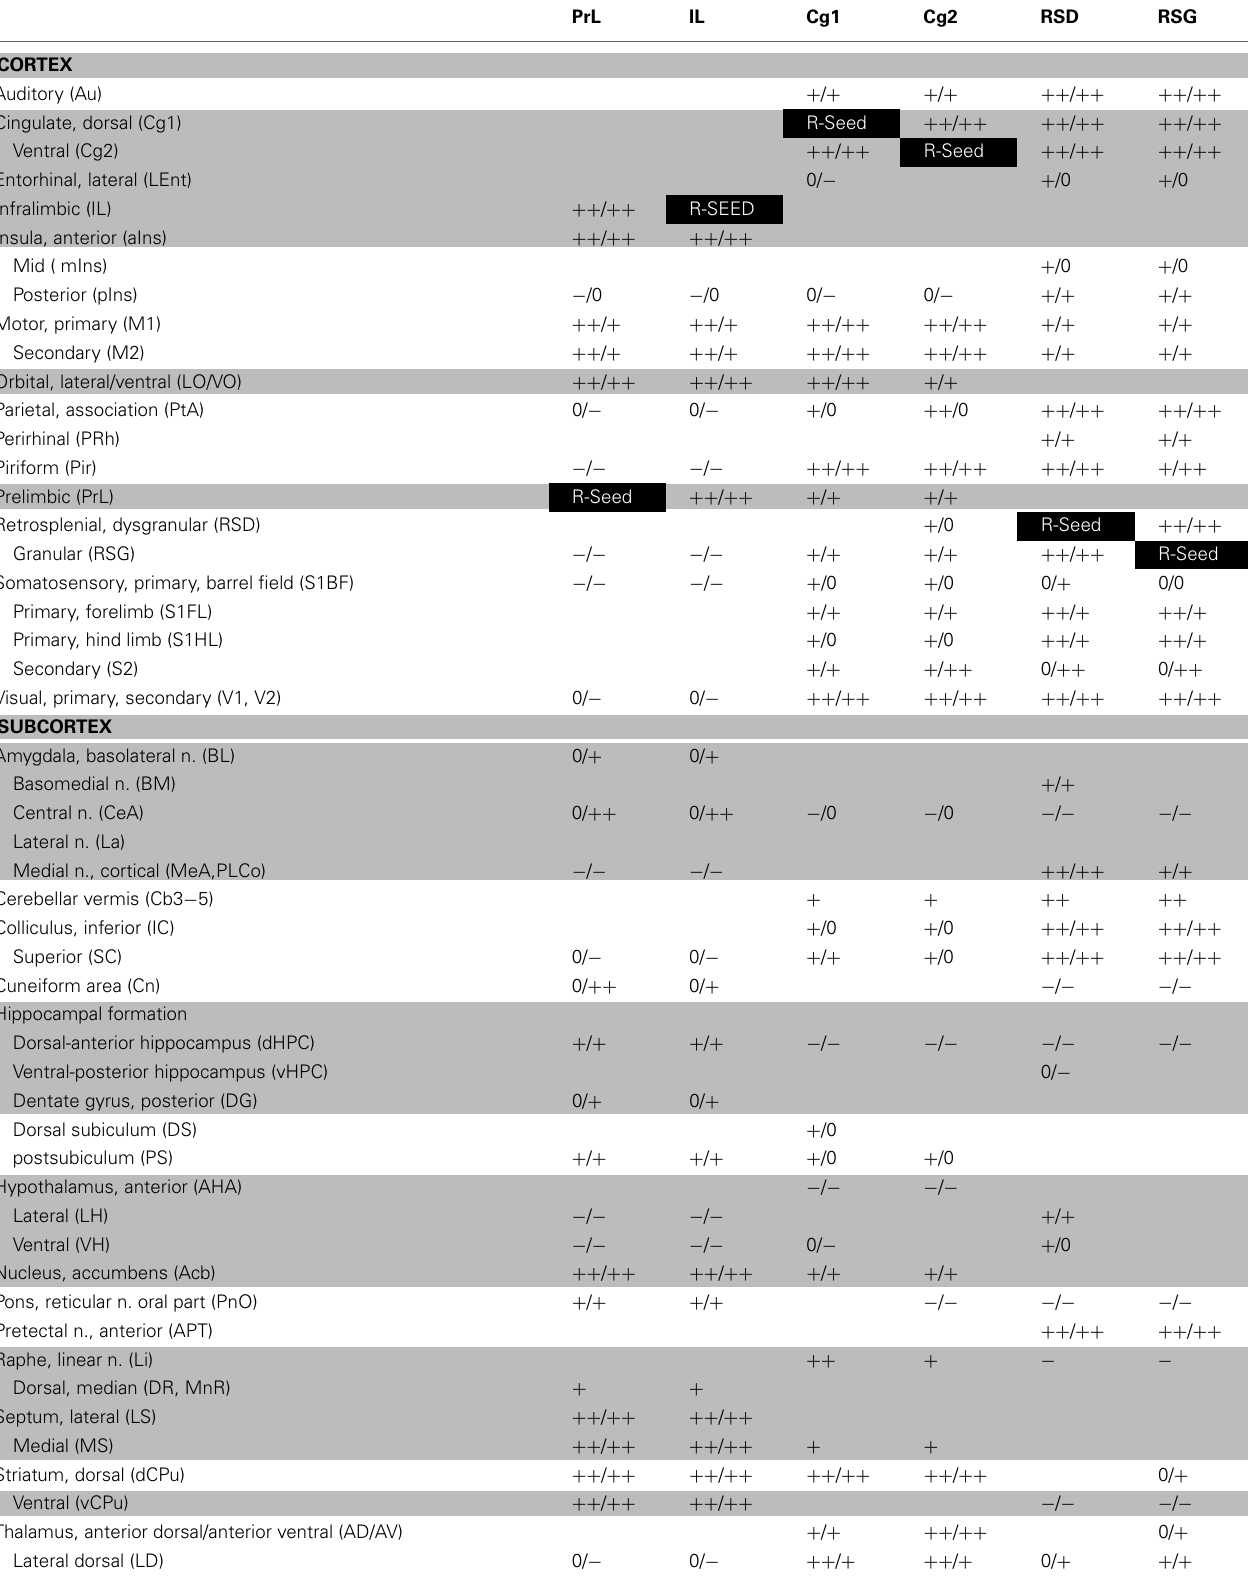
Table 1 | Summary of seed correlation analysis results in the control